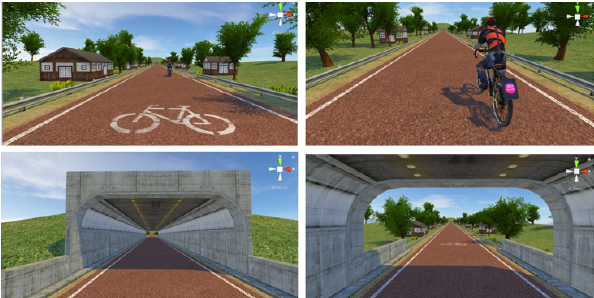
Figure. 6. Screenshots of different scenes in the simulation